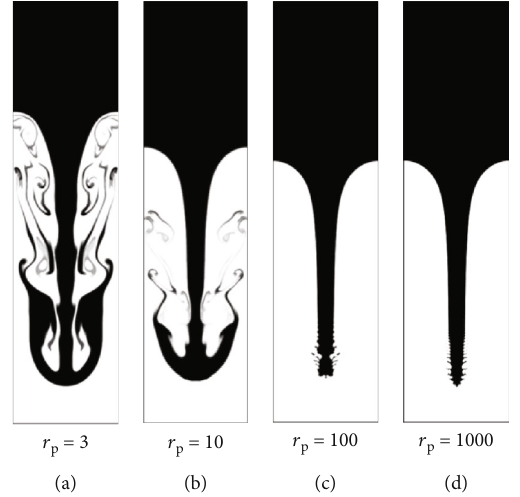
Figure 17: Snapshots of interface shape for di ff erent density ratios ( Re = 10000 and r